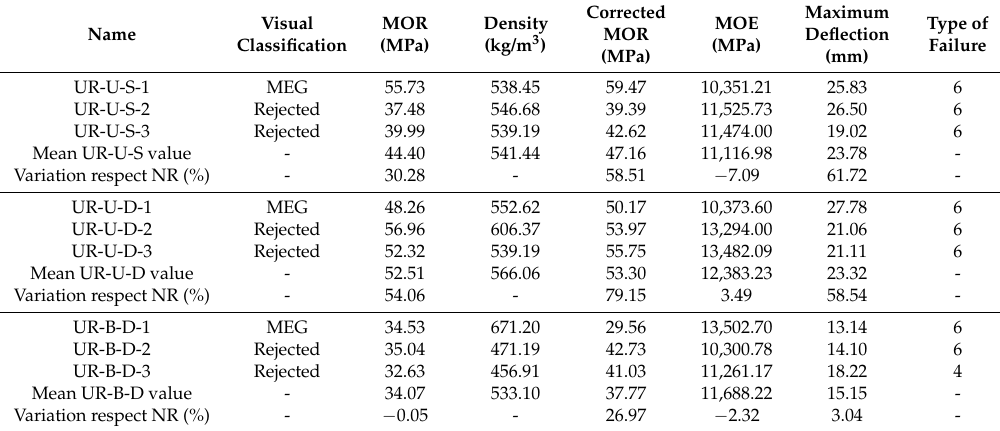
Table 5. Mechanical results obtained from bending tests for UR-U-S, UR-U-D and UR-B-D beams. Visual classification, MOR, density, density-corrected MOR, MOE, maximum deflection and type of failure. CFRP suppliers: SIKA ® and DRIZORO ® .